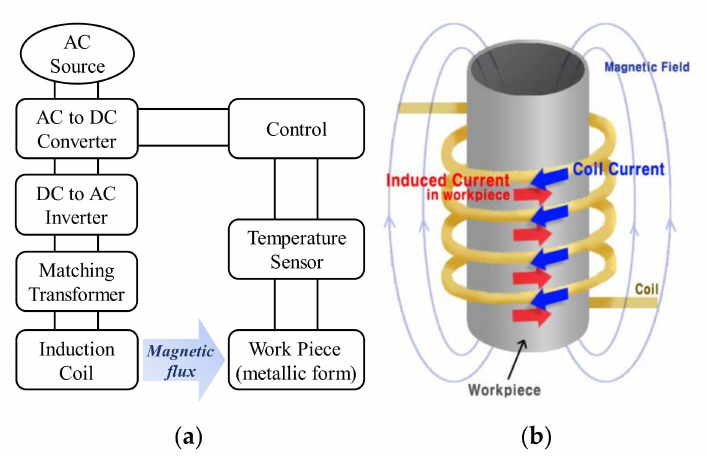
Figure 1. Induction heating system: ( a ) block diagram; ( b ) induction heating principle.